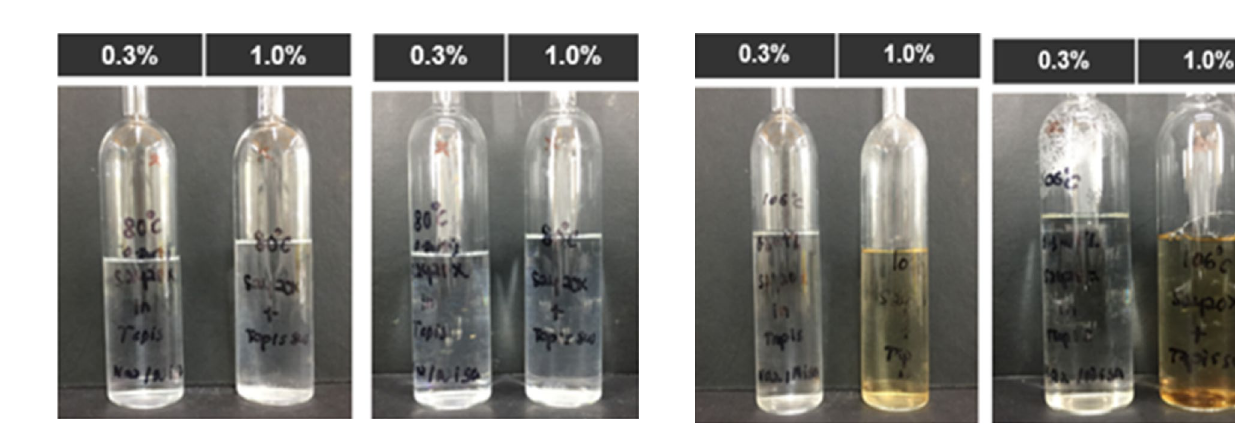
NA test did not perform at this